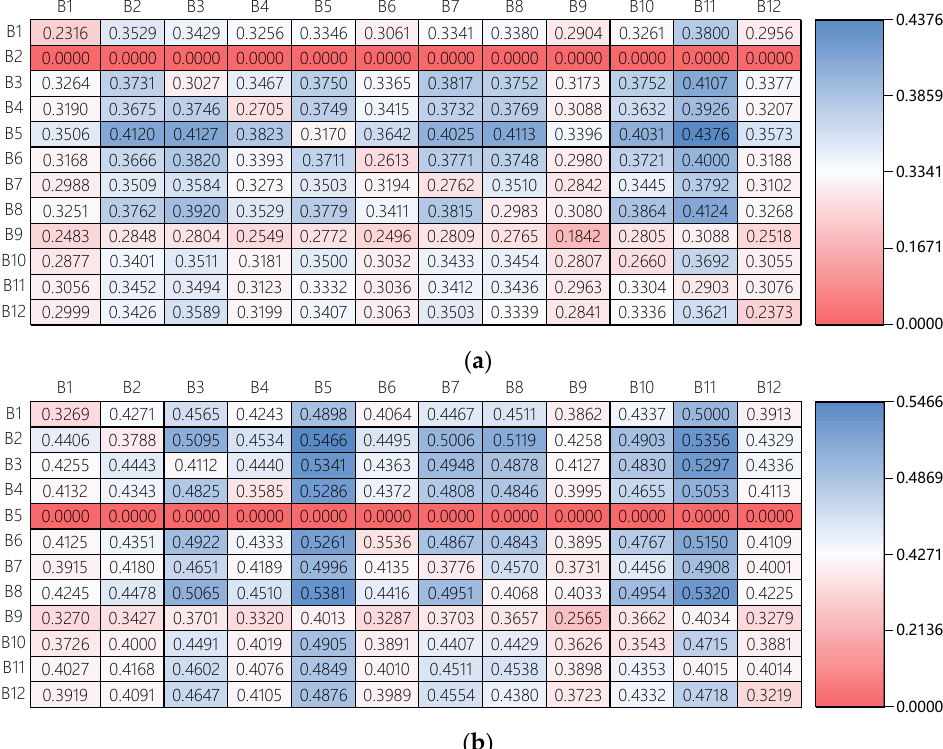
Figure 6. Heatmaps of the total relation matrix for scenario ( a ) and scenario ( b ).